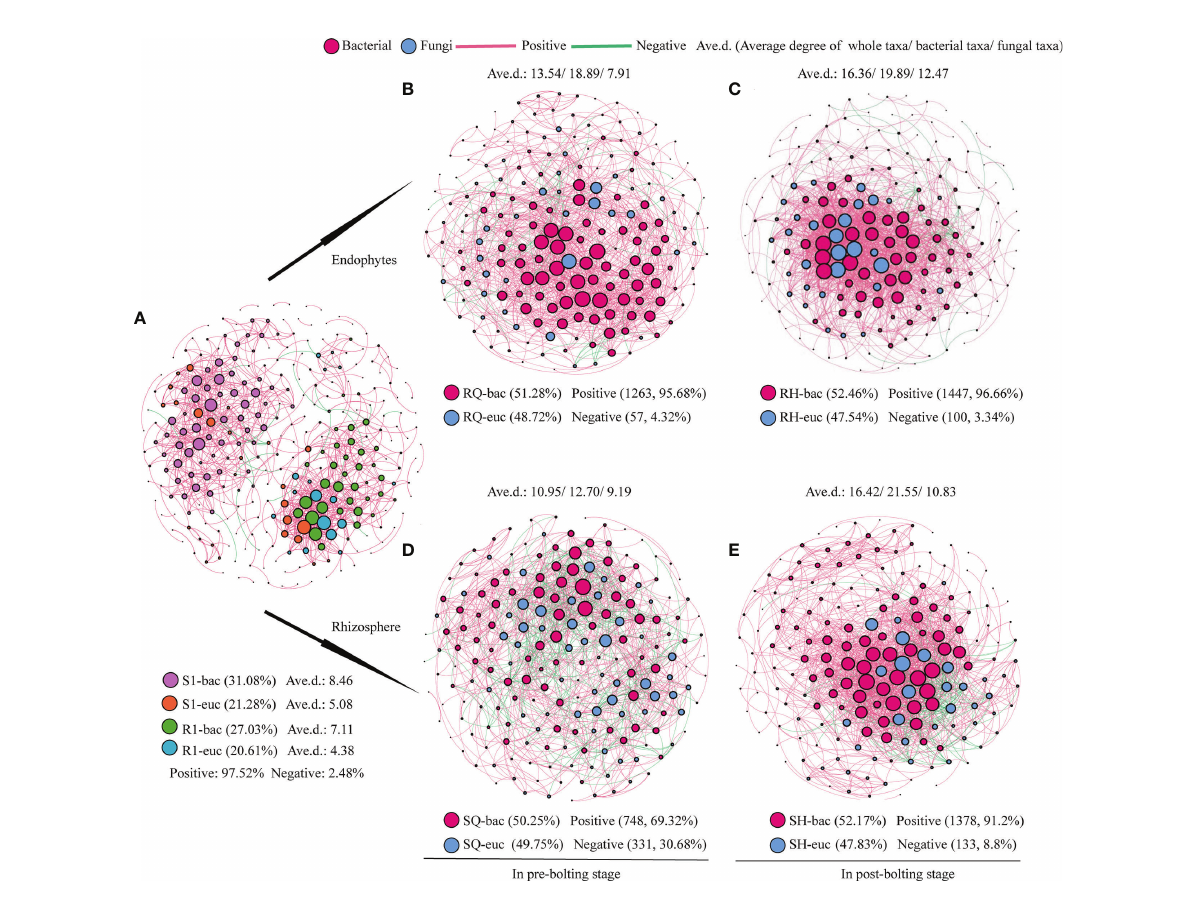
FIGURE 1 Co-occurrence networks of endophytes and rhizosphere microbial community. (A) endophytes and rhizosphere microbial community in the whole growth stage; (B) endophytic bacteria and fungi in pre-bolting stage; (C) endophytic bacteria and fungi in post-bolting stage; (D) rhizosphere bacteria and fungi in pre-bolting stage; and (E) rhizosphere bacteria and fungi in post-bolting